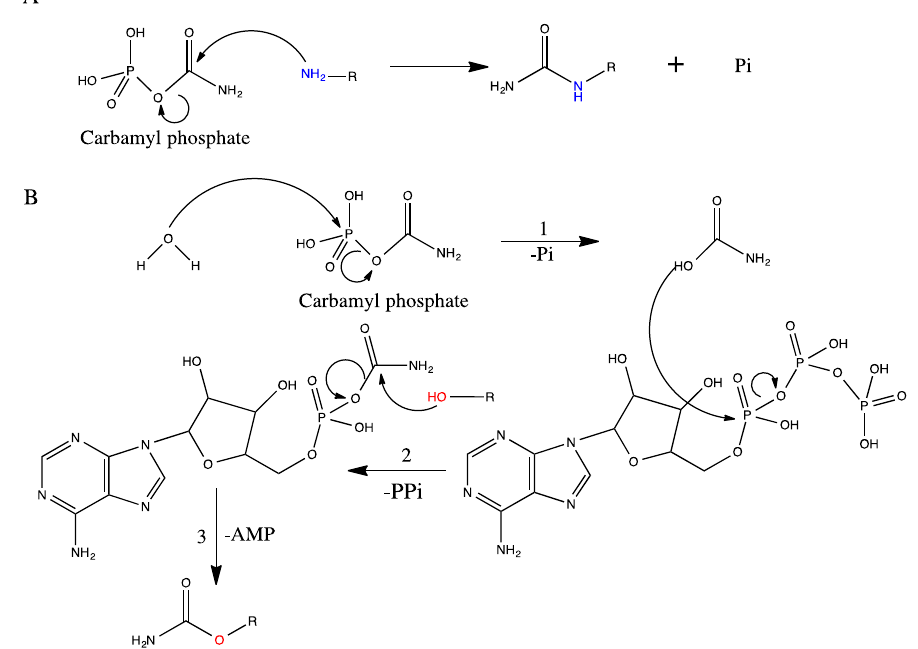
Figure 4. Schematic drawing of the catalytic mechanisms. ( A ) The N- transcarbamylases use the direct attack mechanism for the carbamyl transfer reaction from CP to the amino group; ( B ) The O - transcarbamylases use a three-step reaction for the carbamyl transfer from CP to the hydroxyl group via carbamyladenylate intermediate.